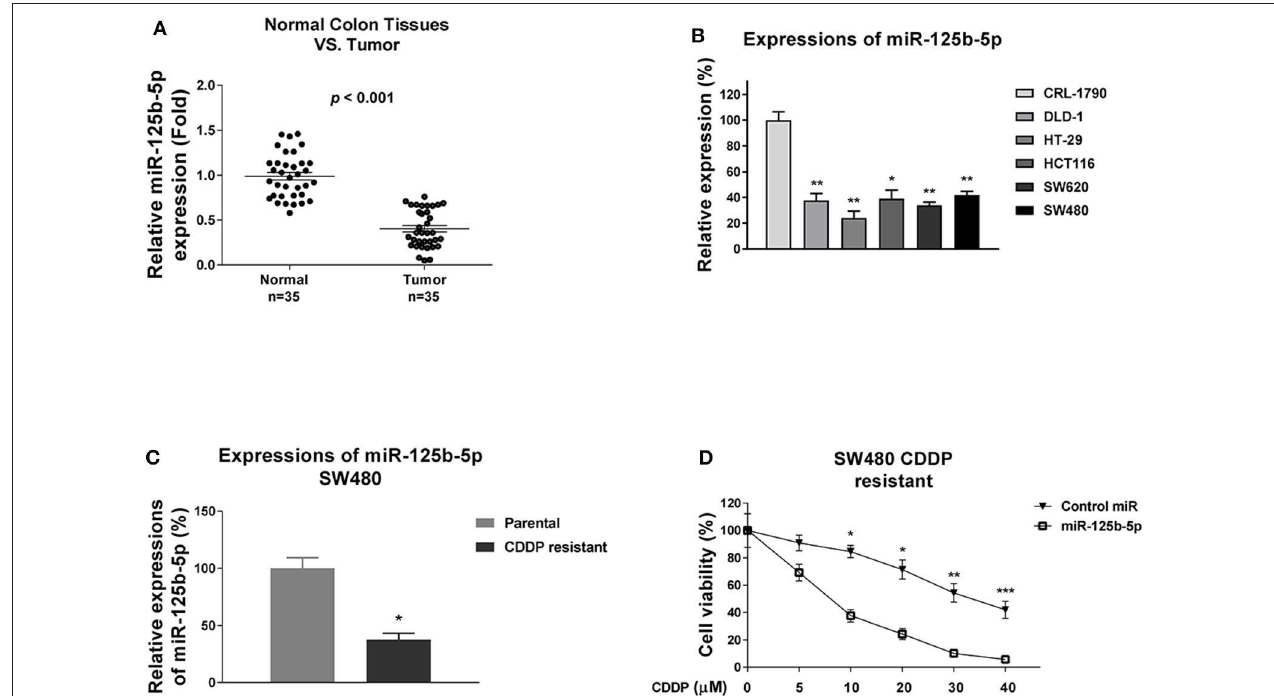
FIGURE 3 | miR-125b-5p is negatively associated with colon cancer and cisplatin resistance. (A) Quantitative RT-PCR results of the miR-125b-5p expressions in 35 normal colon tissues and 35 tumor tissues (B) Quantitative RT-PCR results of the miR-125b-5p expressions in normal colon epithelial cell and five colon cancer cells. (C) Expressions of miR-125b-5p were detected from SW480 parental and cisplatin-resistant cells by qRT-PCT. (D) Cisplatin-resistant SW480 cells were transfected with control miR or miR-125b-5p, followed by cisplatin treatments at the indicated concentrations. Cell viability was measured by MTT assay. Data are presented as